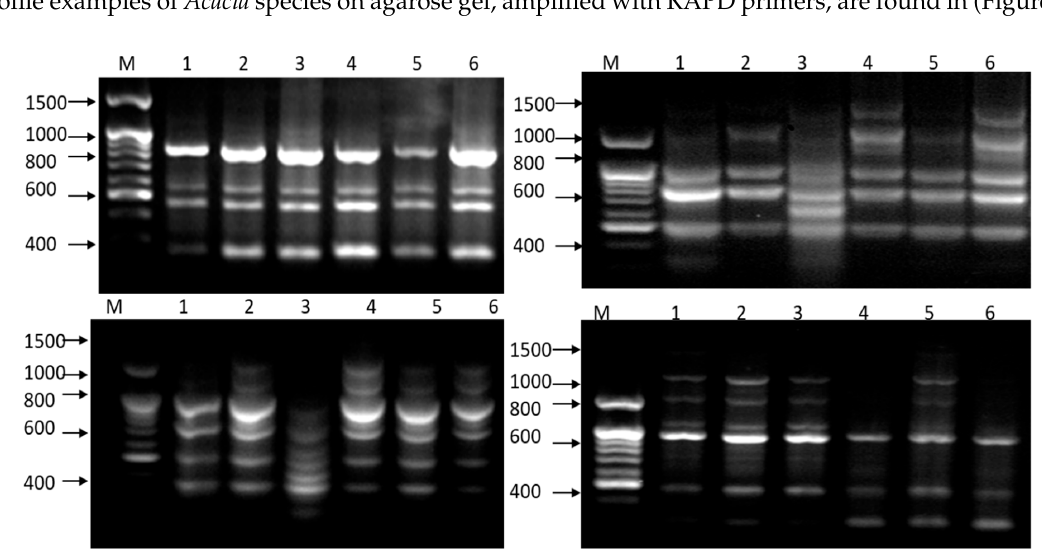
Figure 5. Profile examples of Acacia species on agarose gel, amplified with RAPD primers, i.e., OPB-03, OPB-17, OPB-20 and OPQ-12. M = Molecular marker (200: 1500 bp), (1) A. tortilis ssp. raddiana (Siwa Oasis), (2) A. tortilis ssp. raddiana (Borg Al-Arab), (3) A. stenophylla , (4) A. farnesiana , (5) A. sclerosperma and (6) A. saligna .